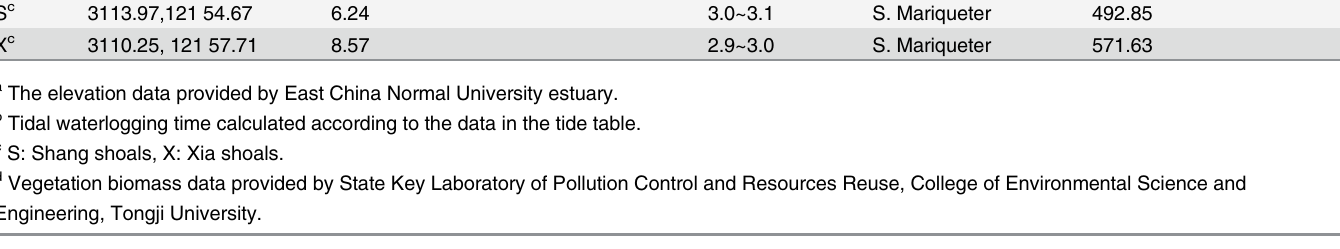
Table 1. The sampling zones station and basic hydrographic and vegetation properties a .